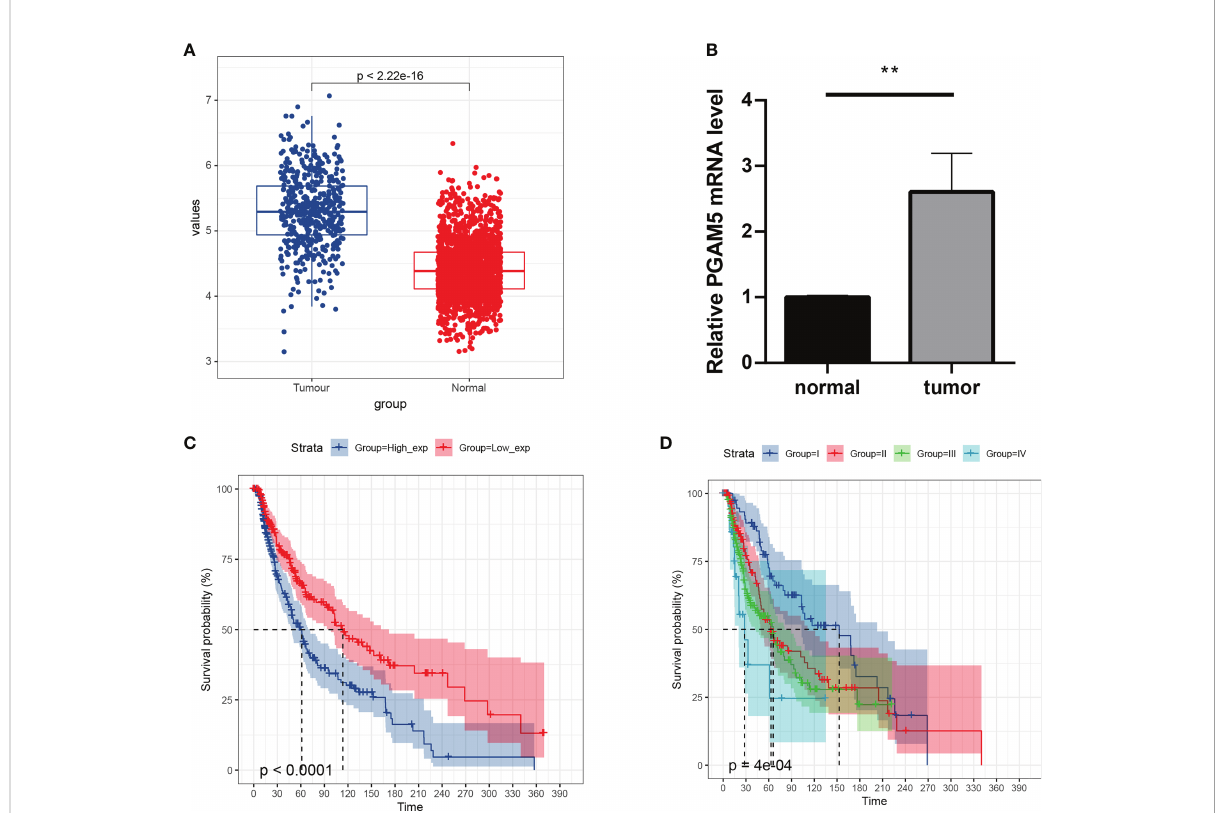
FIGURE 4 Expression and prognosis of pivotal genes. (A) Distribution of PGAM5 expression in cancer and paraneoplastic tissues. (B) Expression level of PGAM5 as determined by qRT-PCR. (C) KM survival curve showing the prognosis of high and low PGAM5 expression. (D) Prognosis of PGAM5 expression in relation to pTNM staging.